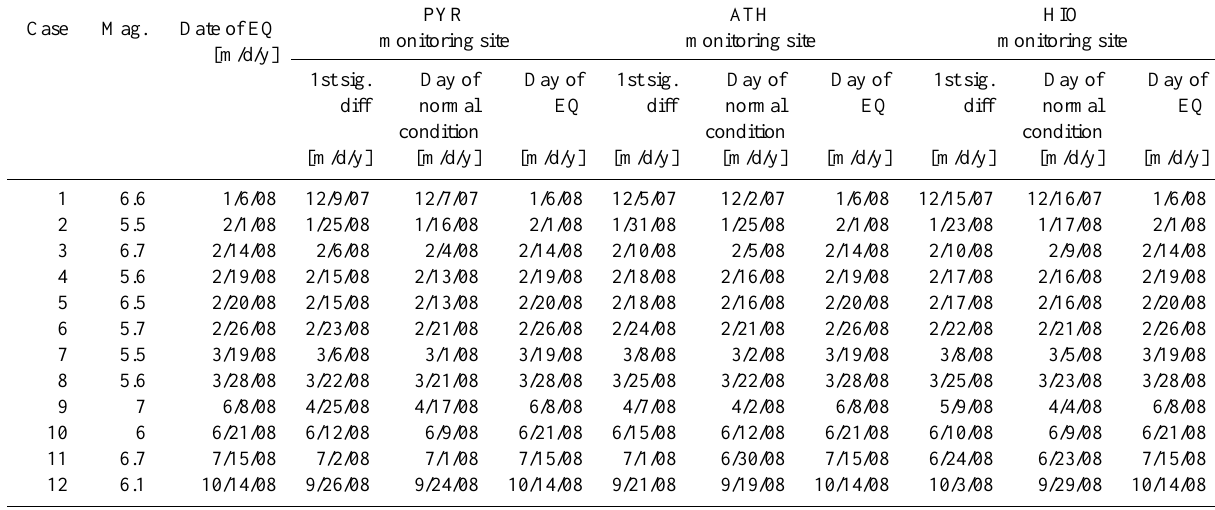
Fig.11. Graphic of ATH Monitoring site three different conditions of GFdiff.